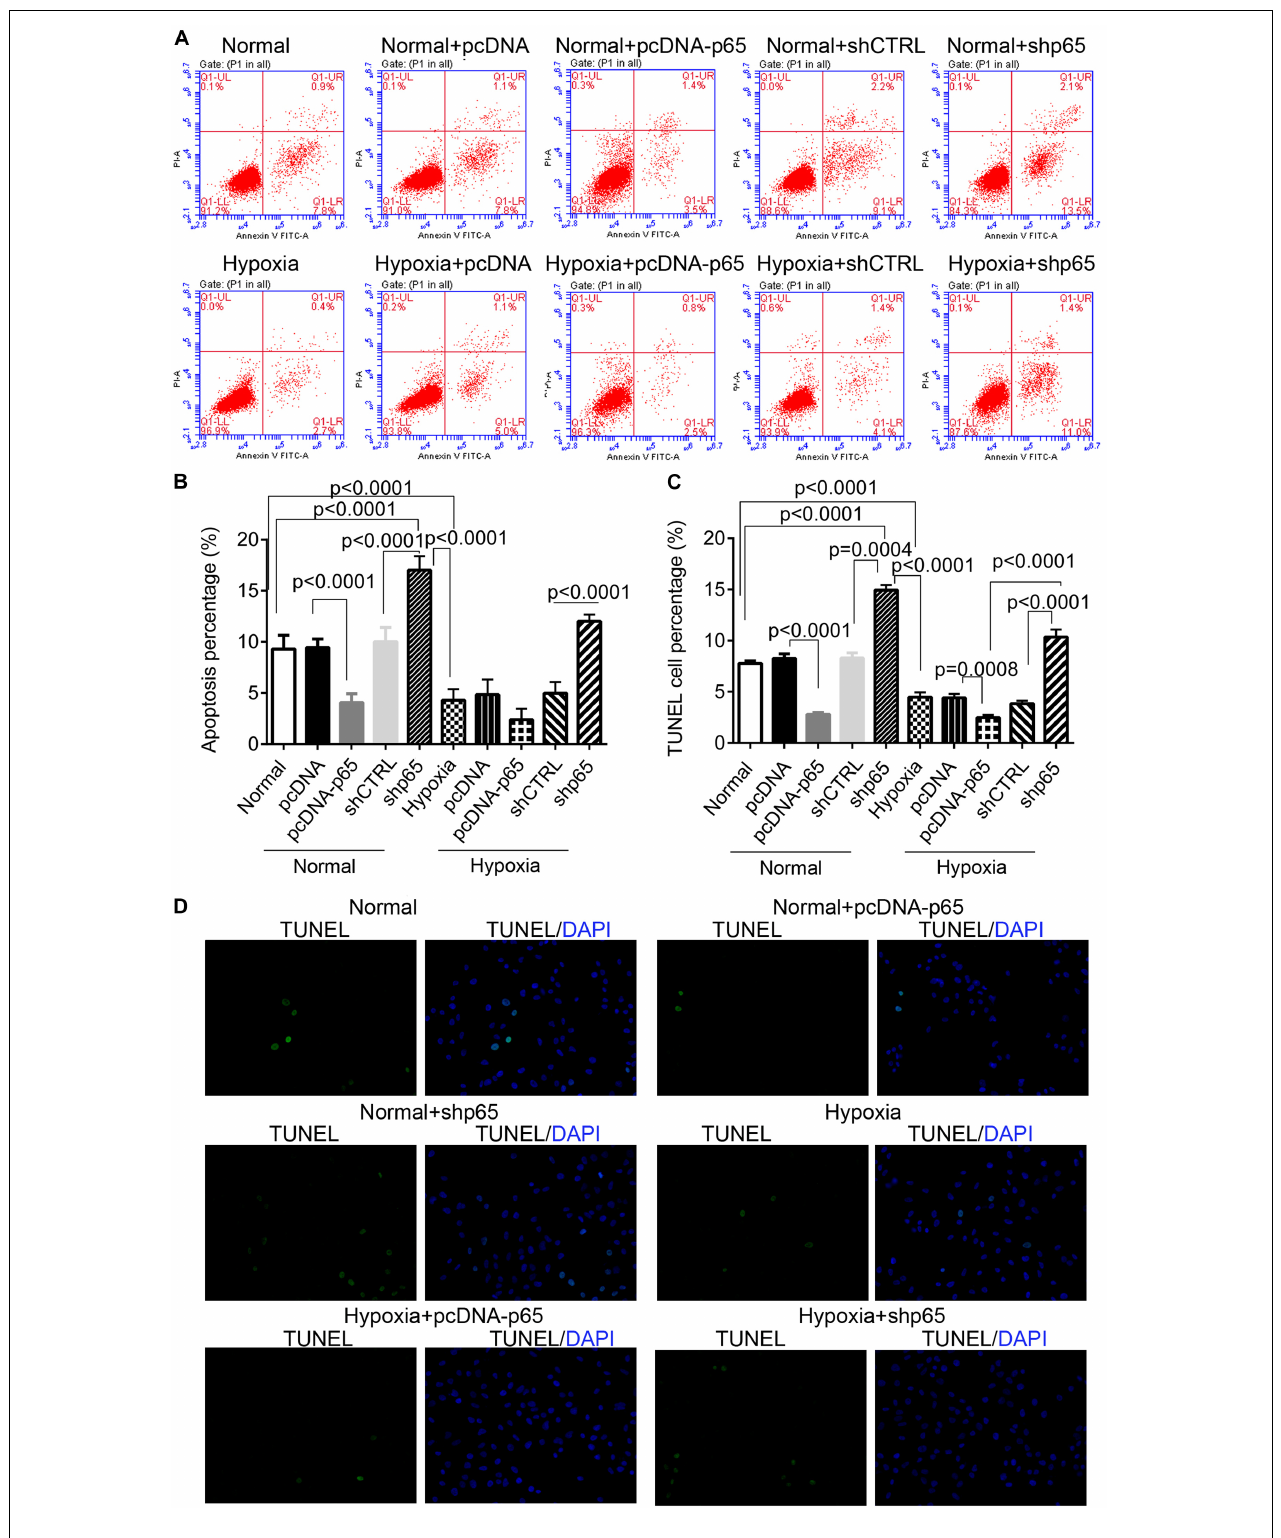
FIGURE 4 | The apoptotic hPASMCs in response to p65 expression and hypoxia treatment. (A,B) The representative images and statistical analysis of the apoptotic percentage in hPASMCs using the flow cytometric analysis. Each experiment was repeated three times. (C,D) The statistical analysis and representative images of the TUNEL assay in hPASMCs. The differences were analyzed using one-way ANOVA. CTRL, control.